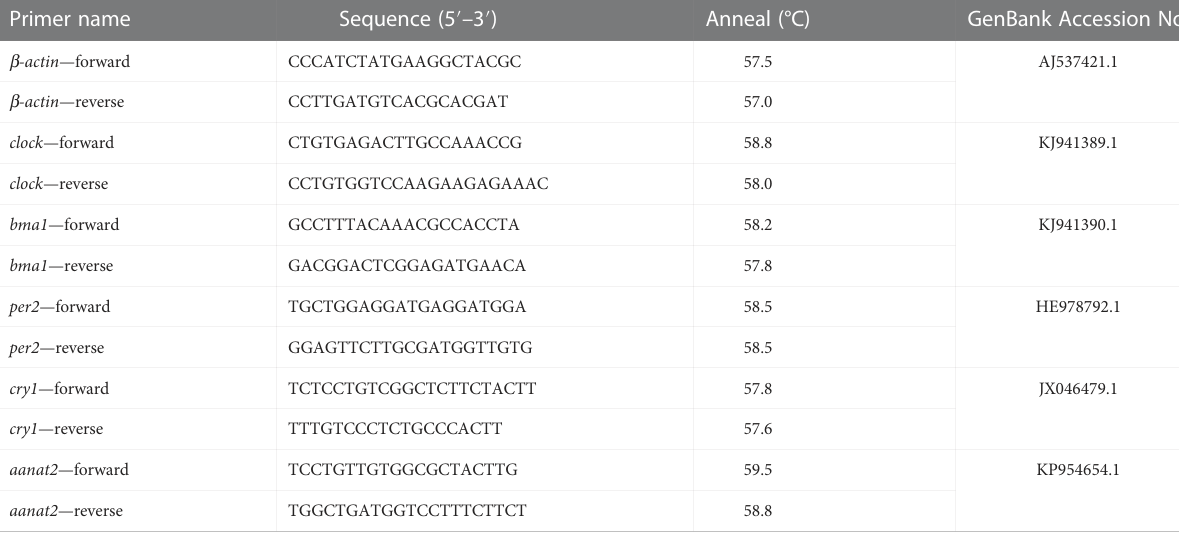
TABLE 1 Primer sequences and annealing temperatures used for